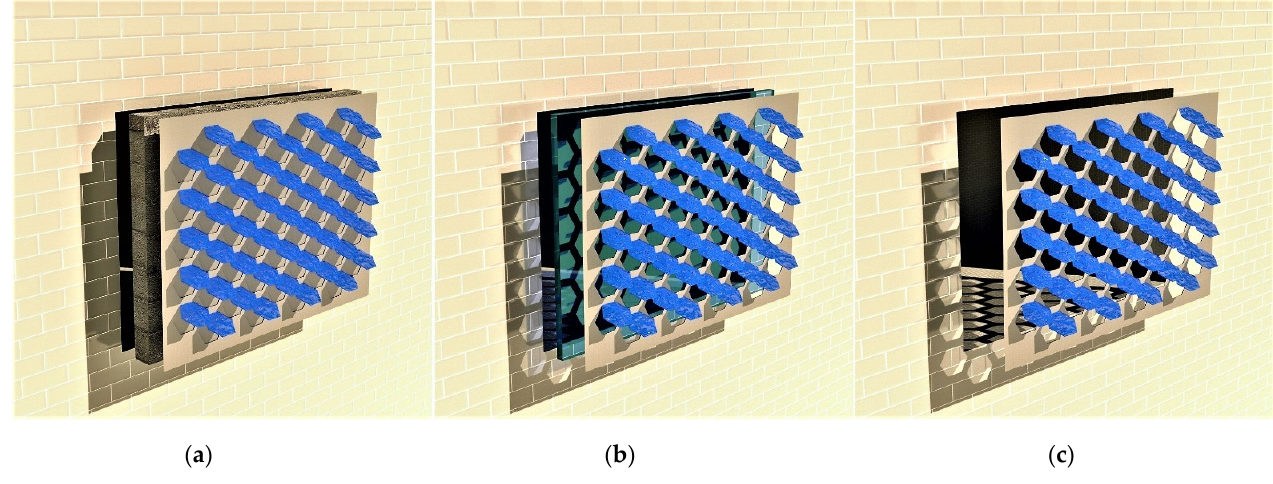
Figure 3. ( a ) ‘Opaque’ configuration. ( b ) ‘Glazing’ configuration. ( c ) ‘Envelope’ configuration.